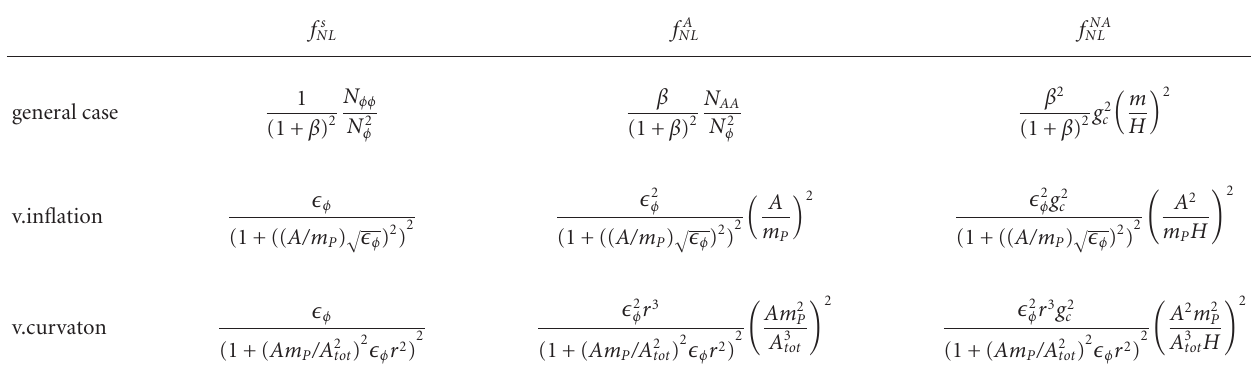
Table 1: Order of magnitude of f NL in di ff erent scenarios.